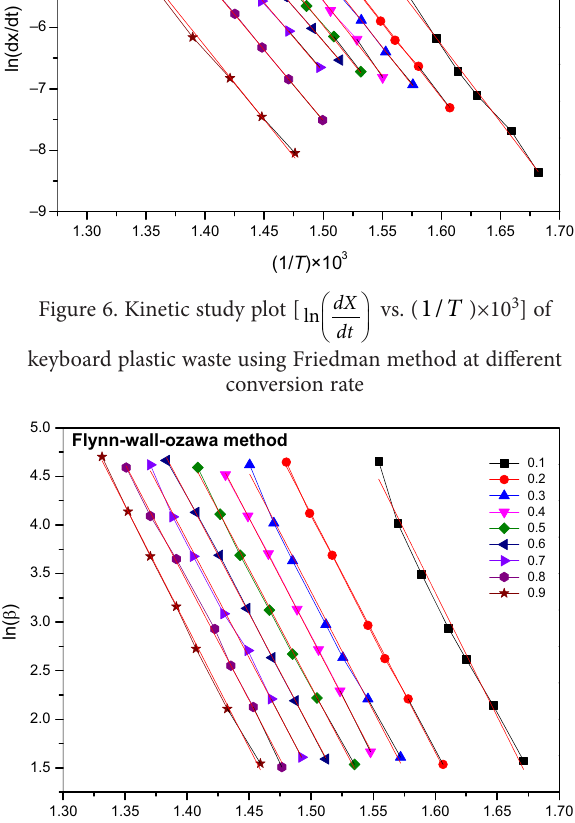
Figure 8. Kinetic study plot [ln( b / T 2 ) vs. (1/ T )×10 3 ] of keyboard plastic waste using Coats-Redfern method at different conversion rates